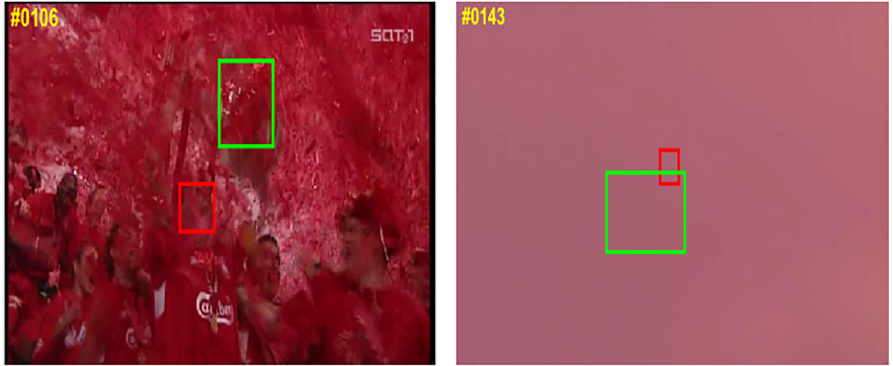
Fig 9. Two cases of failure, in which the red box mean ground truth and the green box mean SGAT